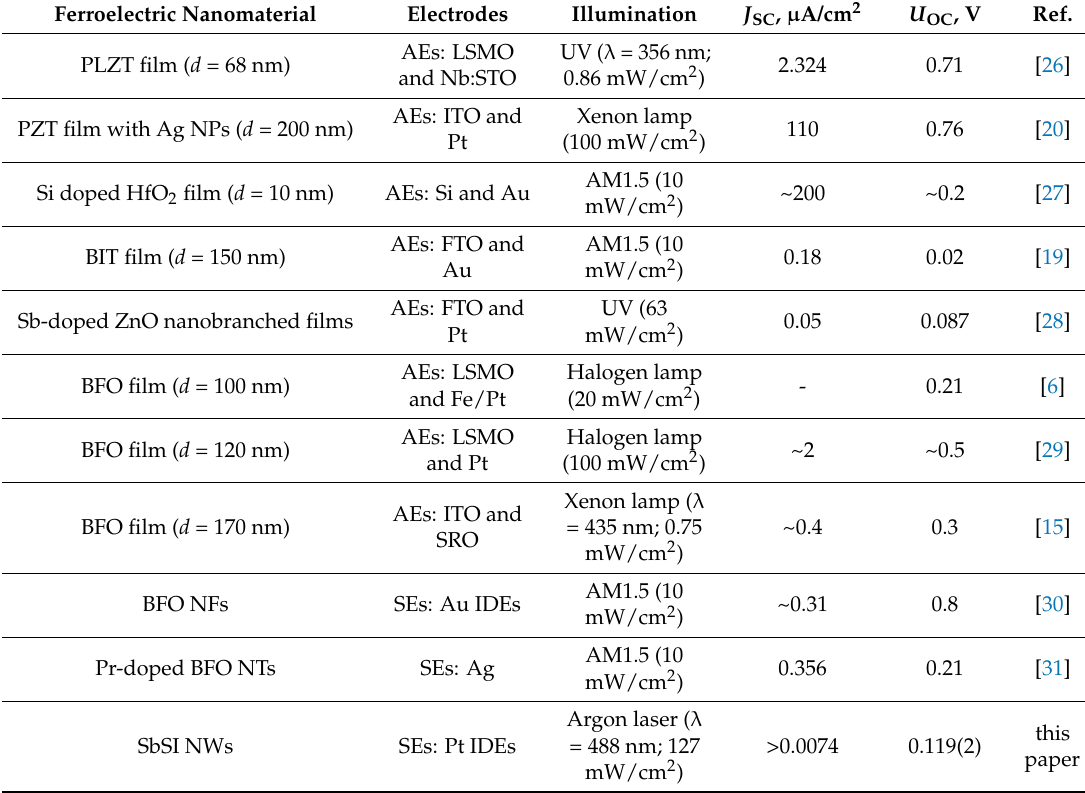
Table 4. A summary of results achieved for photovoltaic devices based on low dimensional ferroelectrics 1